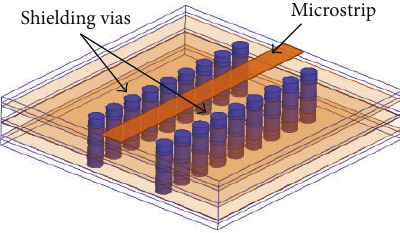
Figure 6: simi-CBCPW structure.